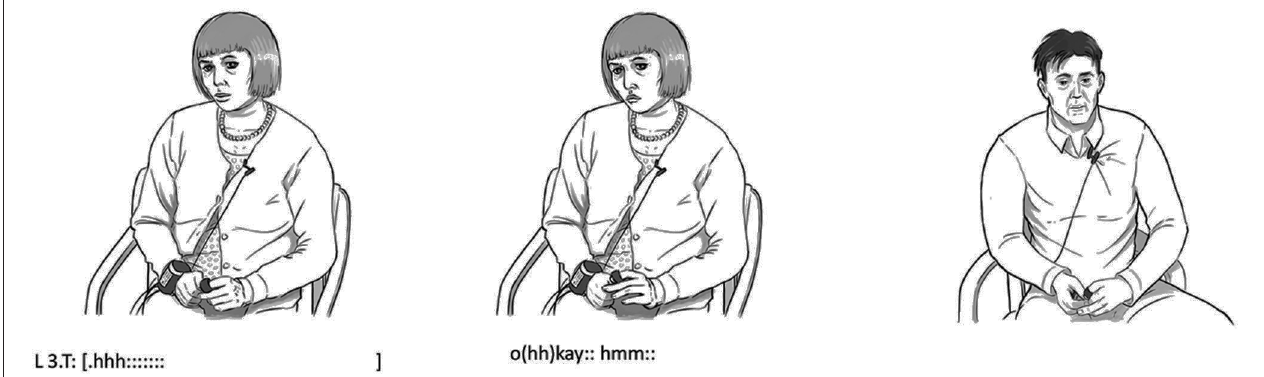
FIGURE 1 | Bodily actions in relation to example 1.